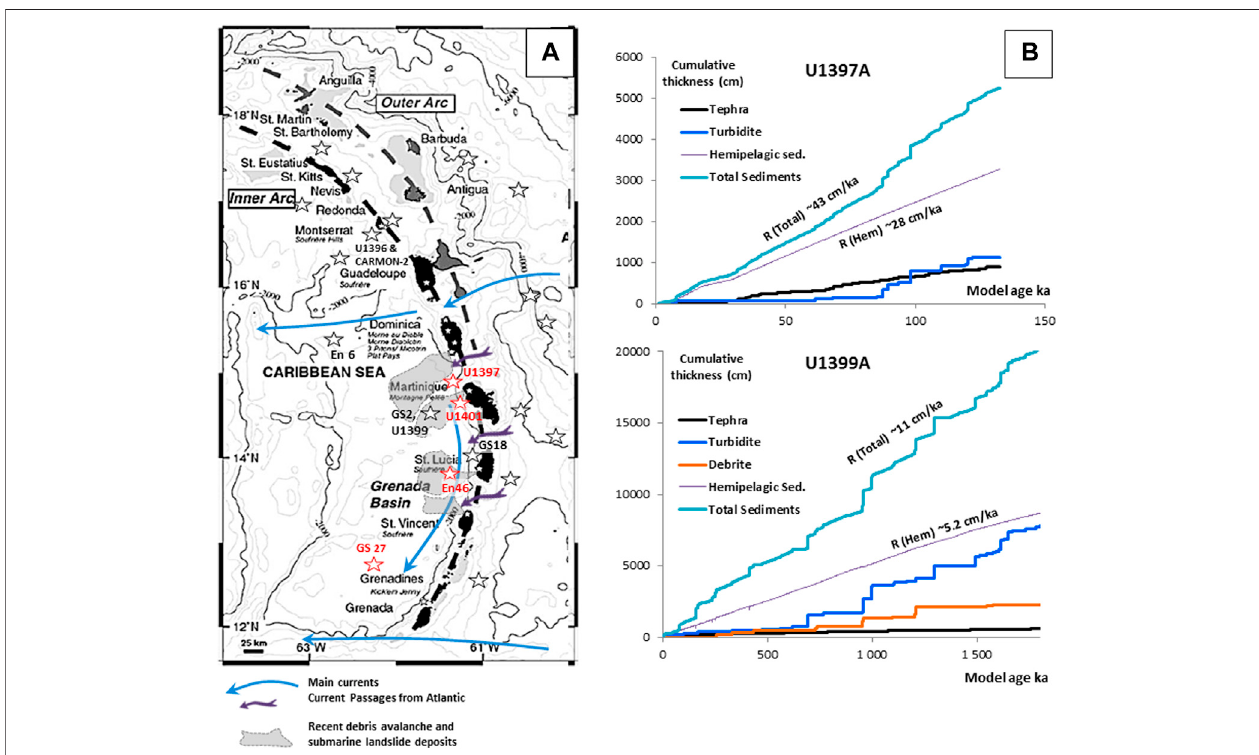
FIGURE 8 | Sedimentation rates. (A) Hemipelagic sedimentation rates in the South Caribbean Sea (Grenada Basin). Red stars: V ° s > 15 cm/ka; black stars V ° s < 8 cm/ka. Data sources: U1397A, U1399 (this work); U1401 (Solaro et al., 2020, modi fi ed); U1396 and CARMON-2 and NE Montserrat; Le Friant et al., 2008; Wall- Palmer et al., 2014 and Fraass et al., 2017); En 6, En 46, GS 2, GS 27, and other coring sites north Guadeloupe: biostratigraphic estimates (Broecker et al., 1990; Reid et al., 1996; Carey 1999). (B) Cumulative sediment thicknesses with time: sites U1397A and U1399A. R (Total) and R(Hem) values are the mean sedimentation rates of hemipelagic and total sediments. It is to be noted that hemipelagic curves are used as a reference (rates are estimated from 14 C and δ 18 O dating for age < 50 ka and beyond are assumed constant; see Figures 5A , 7B ).